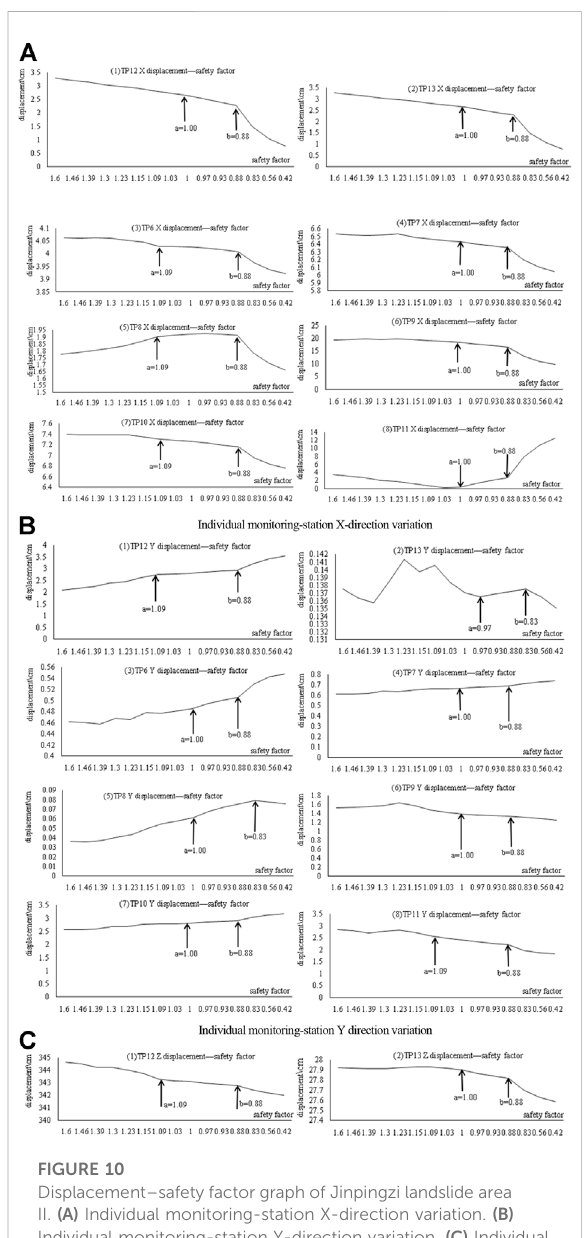
FIGURE 10 Displacement – safety factor graph of Jinpingzi landslide area II. (A) Individual monitoring-station X-direction variation. (B) Individual monitoring-station Y-direction variation. (C) Individual monitoring-station Z-direction variation. (D) Individual monitoring-station displacement variation.